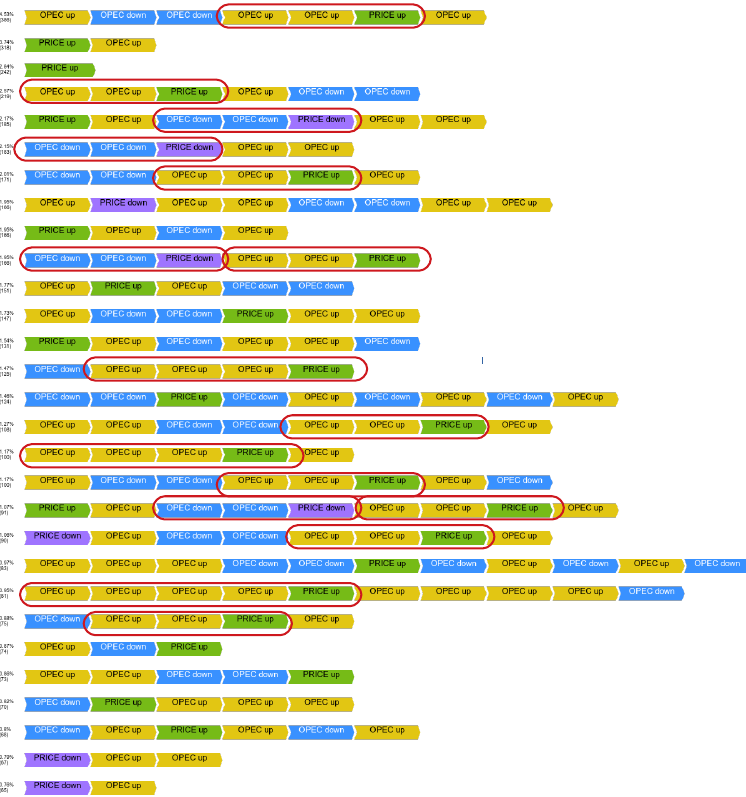
Figure 15. Series of changes generated by Cortado Variant